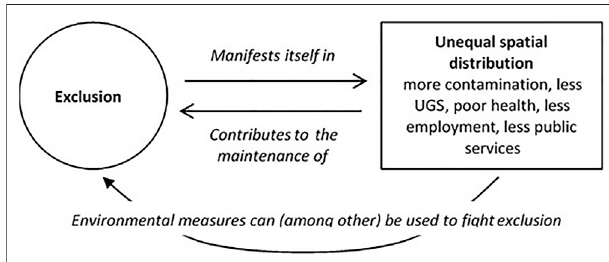
FIGURE 1 | Exclusion and the physical